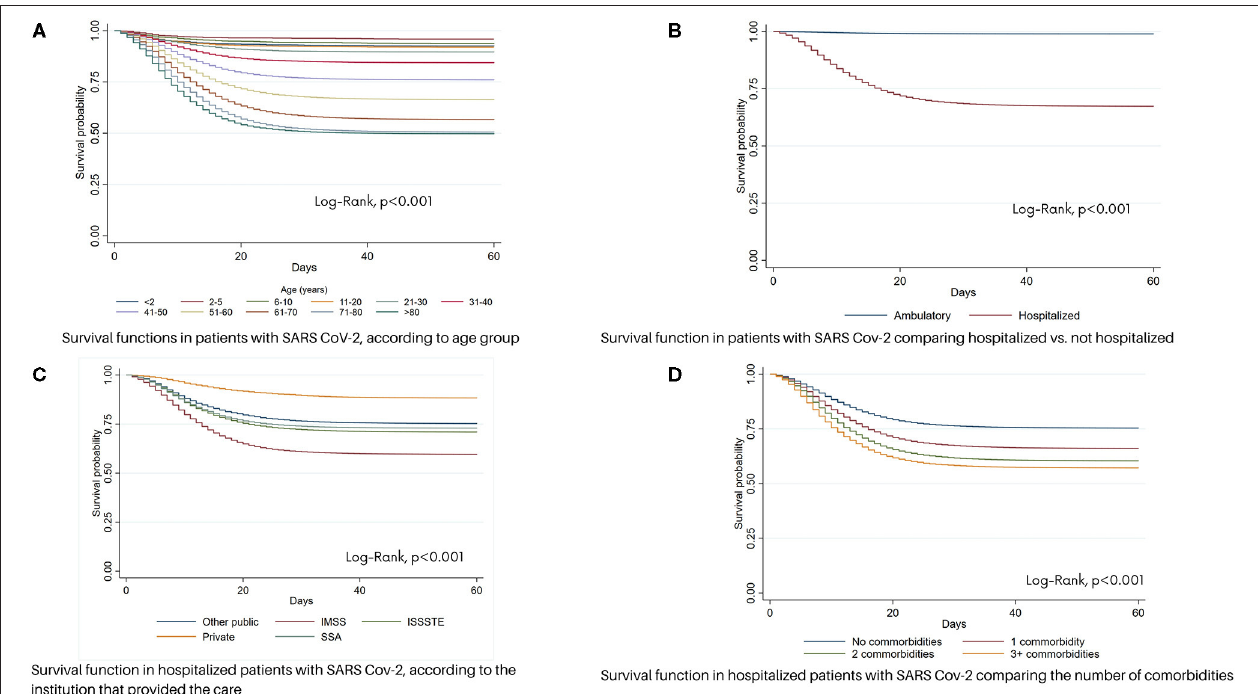
FIGURE 2 | Survival function in patients with SARS Cov-2 in México. (A) Survival functions in patients with SARS Cov-2, according to age group. (B) Survival functions in patients with SARS Cov-2 comparing hospitalized vs. non- hospitalized. (C) Survival function in hospitalized patients with SARS Cov-2, according to the institution that provided the care. (D) Survival function in hospitalized patients with SARS Cov-2 comparing the number of